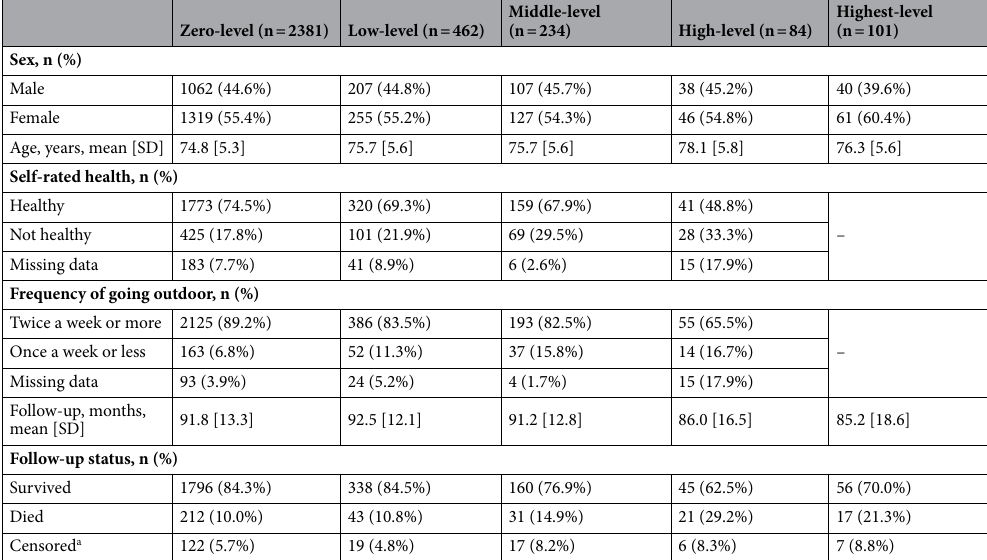
Table 2. Characteristics of participants in follow-up surveys by disengagement levels (N = 3262). IADL Instrumental Activities of Daily Living, SD standard deviation. a Censored participants included those who moved away and refused to respond to the surveys during the follow-up period.